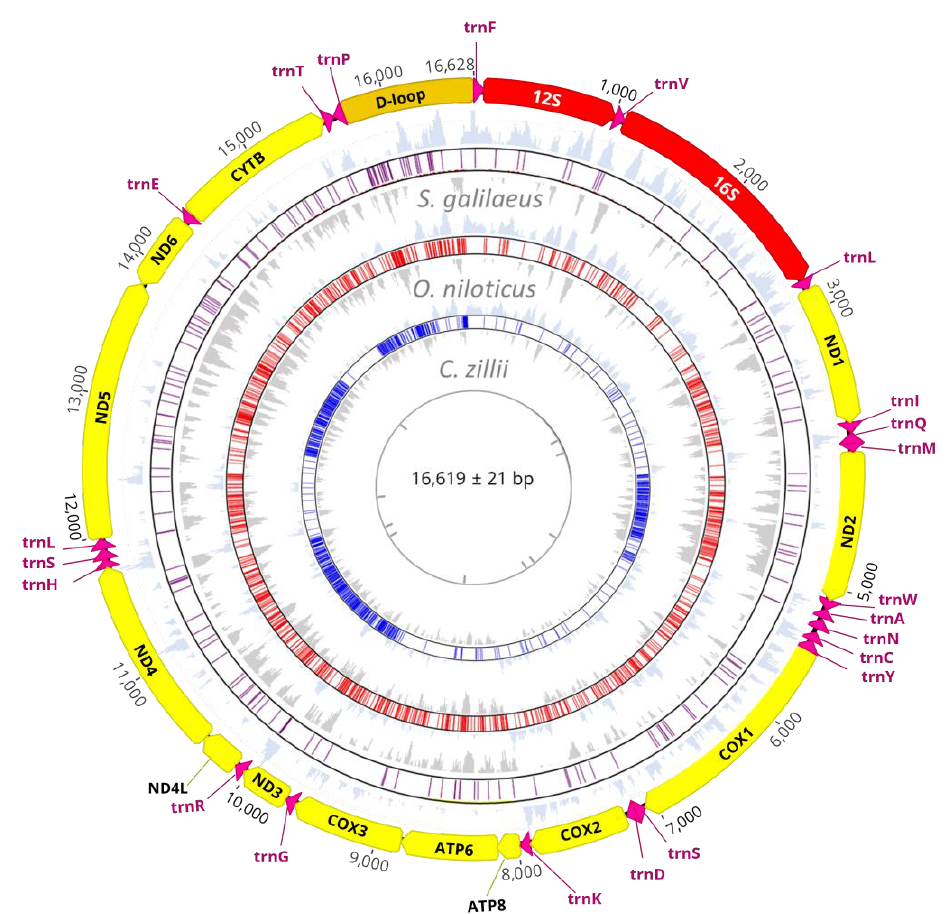
Figure 1. Genetic features and organization of the complete mitochondrial DNA sequence of the Nile tilapiine mitogenomes. The label’s color represents mitogenomes genes: CDS (yellow), tRNAs (dark pink), rRNAs (red), and the control region (D-loop; gold). The direction of genes is indicated by the arrows, and the genes with the clockwise arrows are encoded on the heavy strand, while the genes with the anticlockwise arrows are encoded on the light strand. SNP distribution in all genes is described in each species with highlighted tracks with different colors and laminated by tracks representing GC skews. Purple color represents C. zillii, red represents O. niloticus, blue represents S. galilaeus, gray represents SNPs shared between species, light gray represents GC skews (+), and light blue represents GC skews (−).